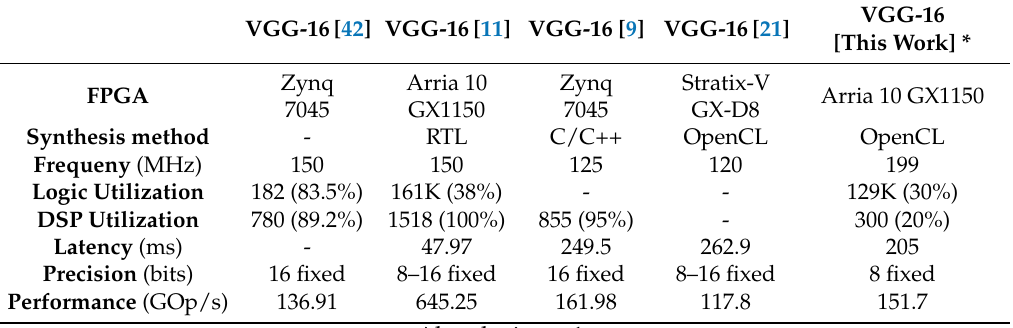
Table 4. Comparison to the existing works VGG-16 with hardware options ( N i , N l ) = ( 16,32 )